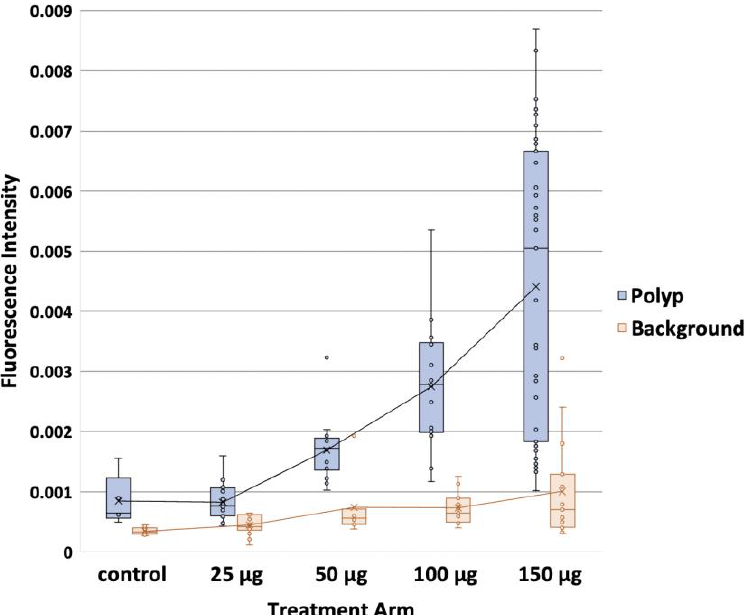
Figure 3. Box plots of polyp and background tissue fluorescence intensity for CPC-APC mice 48 h after administration of various doses (25 μg, 50 μg, 100 μg, and 150 μg) of MUC5AC-IR800 or IRDye800 as control. Mean values are denoted by x within box plots with the mean line is shown.